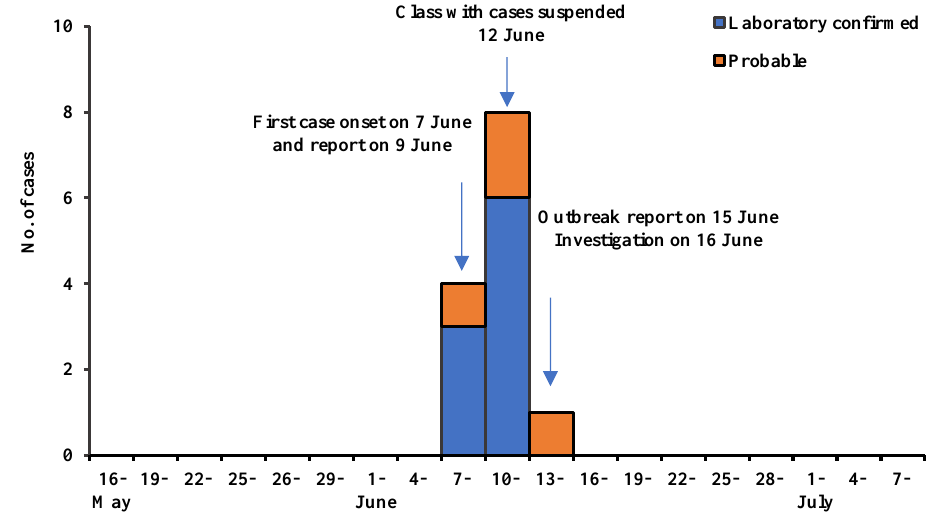
Figure 1. Time distribution of reported varicella cases.